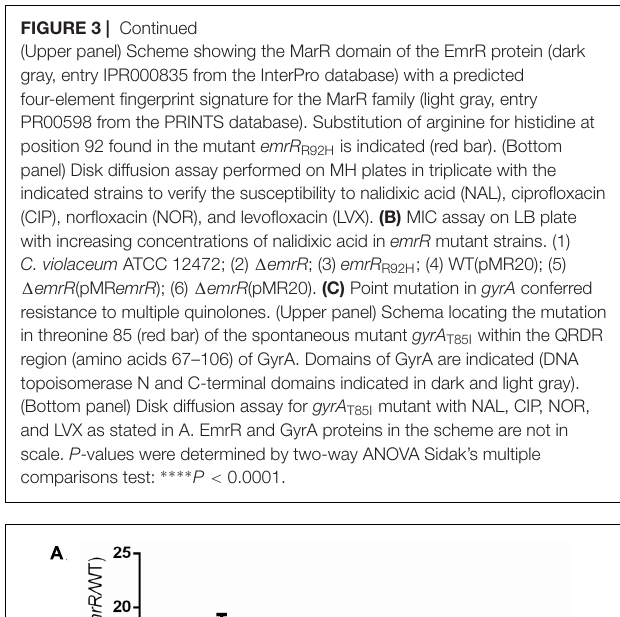
FIGURE 3 | Point mutations in EmrR and GyrA confer distinct levels of quinolone resistance in C. violaceum . (A) Profile of quinolone resistance in the spontaneous mutant emrR R92H indicated specific resistance to nalidixic acid.